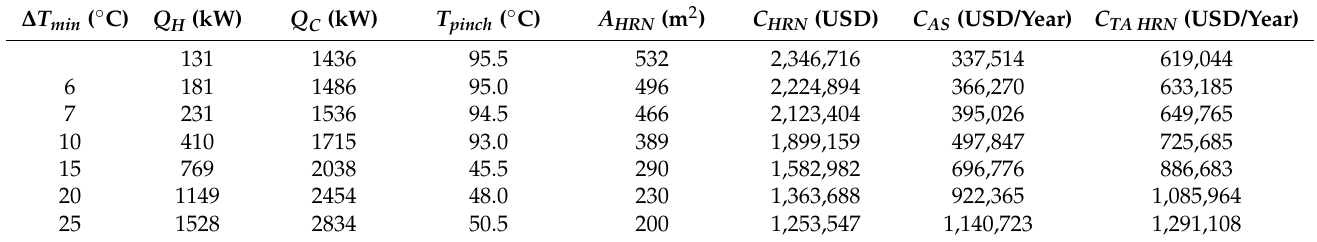
Table 9. Minimum energy requirements and costs of the heat recovery network for different ∆ T min